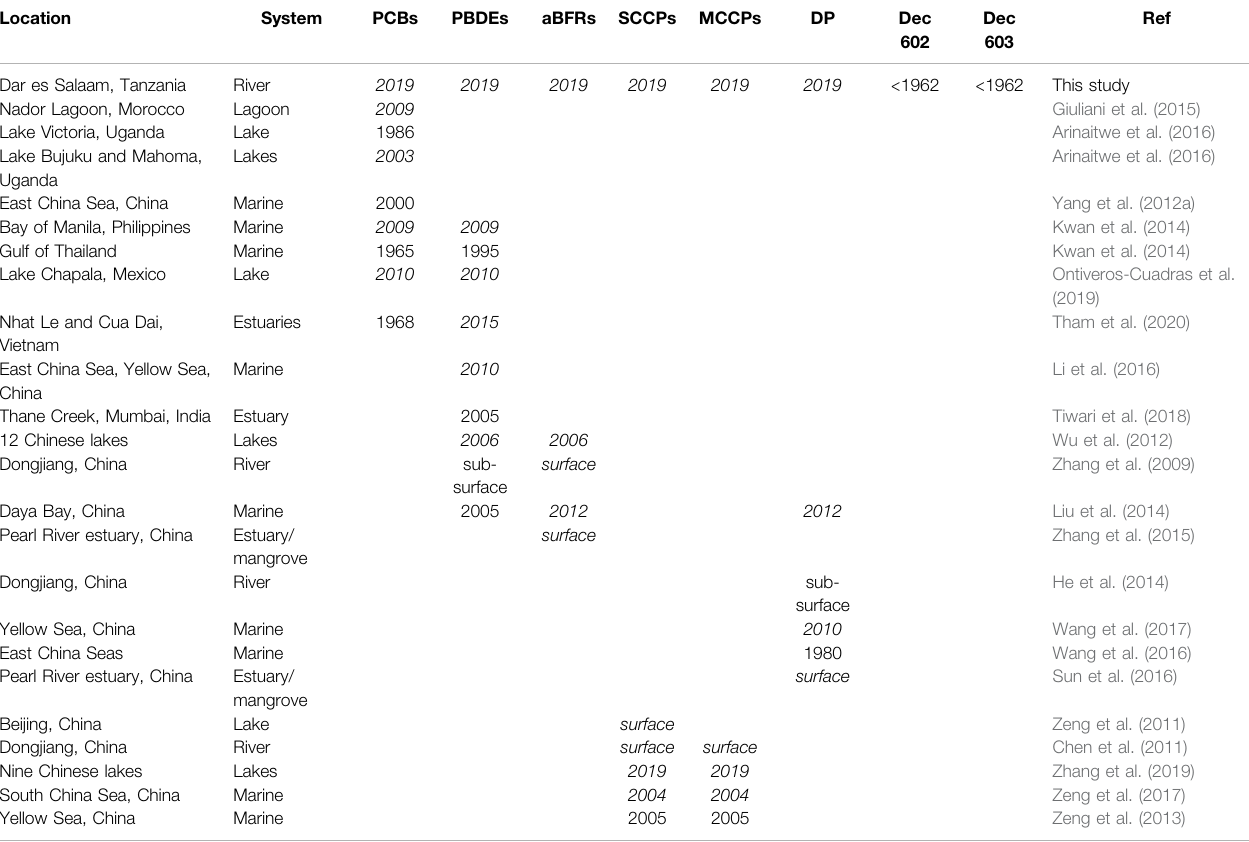
TABLE1| ApproximateyearofpeakconcentrationofPCBs,PBDEs,aBFRs,CPs,anddechloranesinthestudiedsedimentcoreandinsedimentcoresfromdevelopingand newly industrialized regions, compiled from literature.